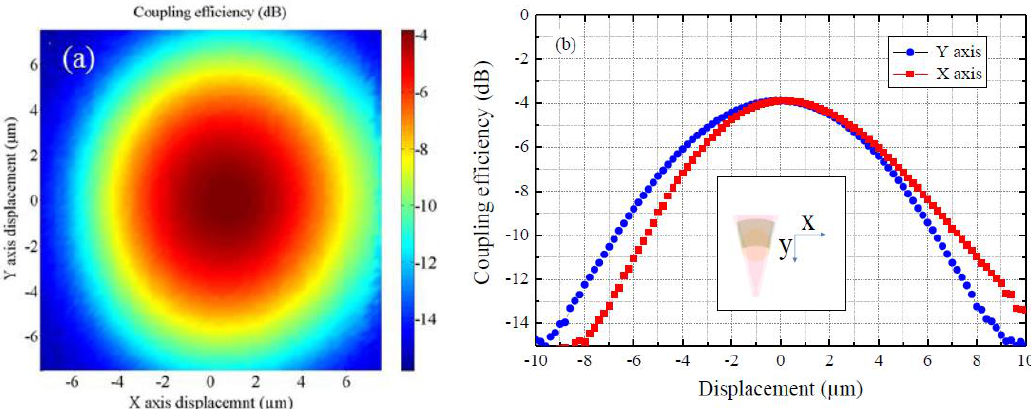
Figure 7. ( a ) Grating coupler alignment tolerance measurement. ( b ). X and Y scan of the fibre on the grating coupler plane showing about 1 dB of extra insertion losses with a fibre displacement of ± 2.5